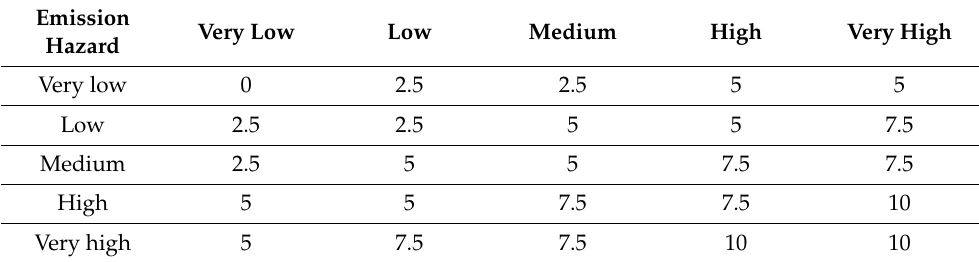
Table 2. Calculating the risk index based on health hazard and emission.